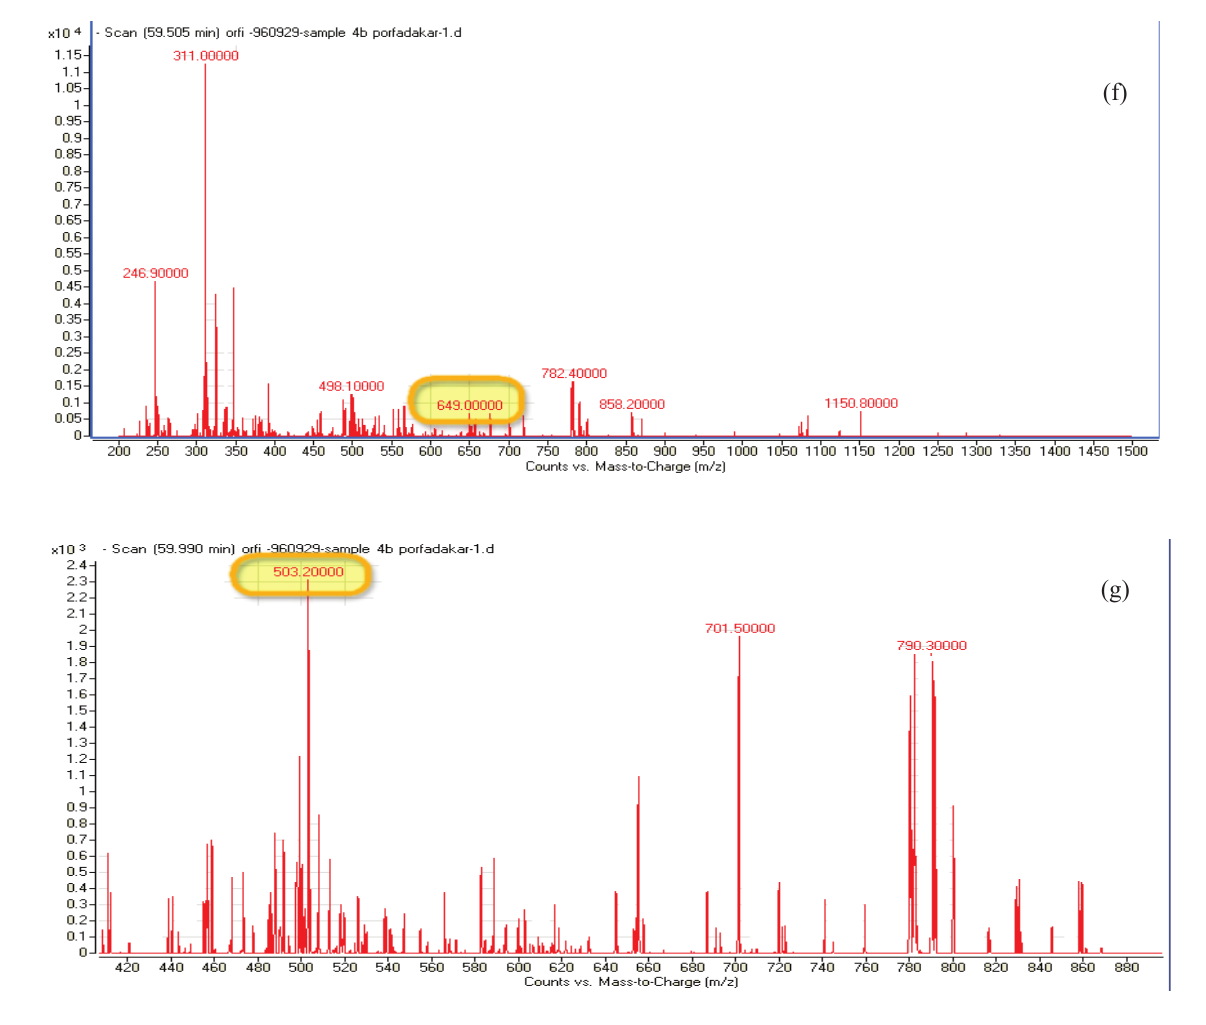
Fig. 6 LC-MS-MS analysis of the rhamnolipids produced by Pseudomonas stutzeri Z12